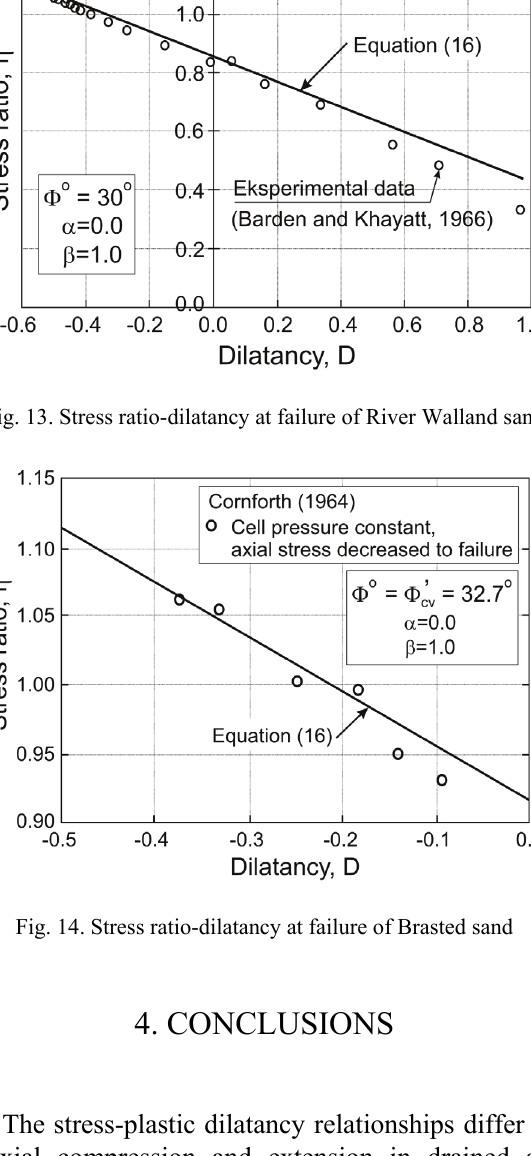
Fig. 12. Stress ratio-dilatancy for sand in drained triaxial extension tests